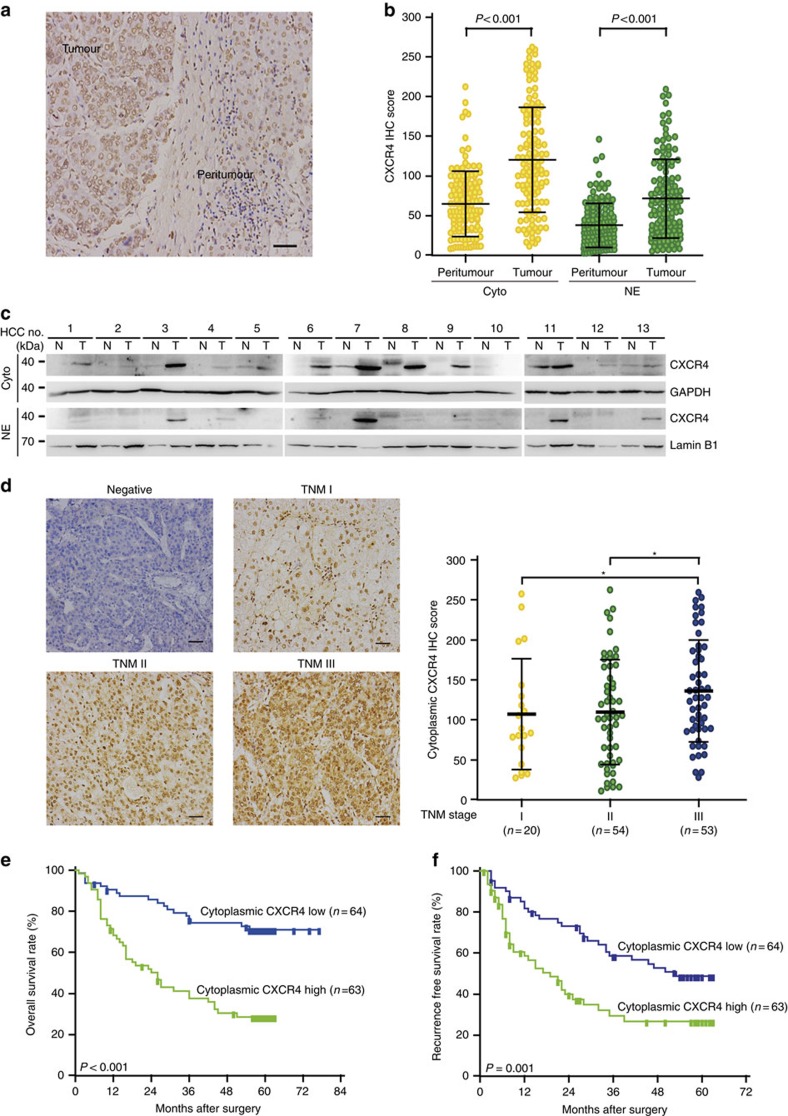
Upregulation of CXCR4 in HCC correlated with poor patient survival.(a) Representative immunohistochemistry (IHC) staining with CXCR4 (scale bar, 50 μm). (b) Scatter plots for corresponding evaluated IHC score in tumour and peritumour HCC specimens (n=127). The horizontal lines in the plots represent the median and the interquartile range. The P values were calculated using Student's t-test. (c) Western blot analysis of CXCR4, GAPDH in cytoplasmic extracts (Cyto) and CXCR4, lamin B1 in nuclear extracts (NE) in HCC specimens. Data are representative immunoblots of three independent assays. (d) Representative IHC staining with CXCR4 from TNM stage I to III of HCC specimens (scale bar, 50 μm)(left panel). Scatter plots for corresponding evaluated IHC score from TNM stage I to III of HCC specimens (right panel). Error bars represent mean±s.d. IHC scores were compared by one-way analysis of variance and Student's t-test, *P<0.05. (e,f) Kaplan–Meier plots indicate the overall survival (e) and RFS (f) for HCC patients categorized by CXCR4 expression (n=63 for high-CXCR4 group versus n=64 for low-CXCR4 group), P value is determined by log-rank test.